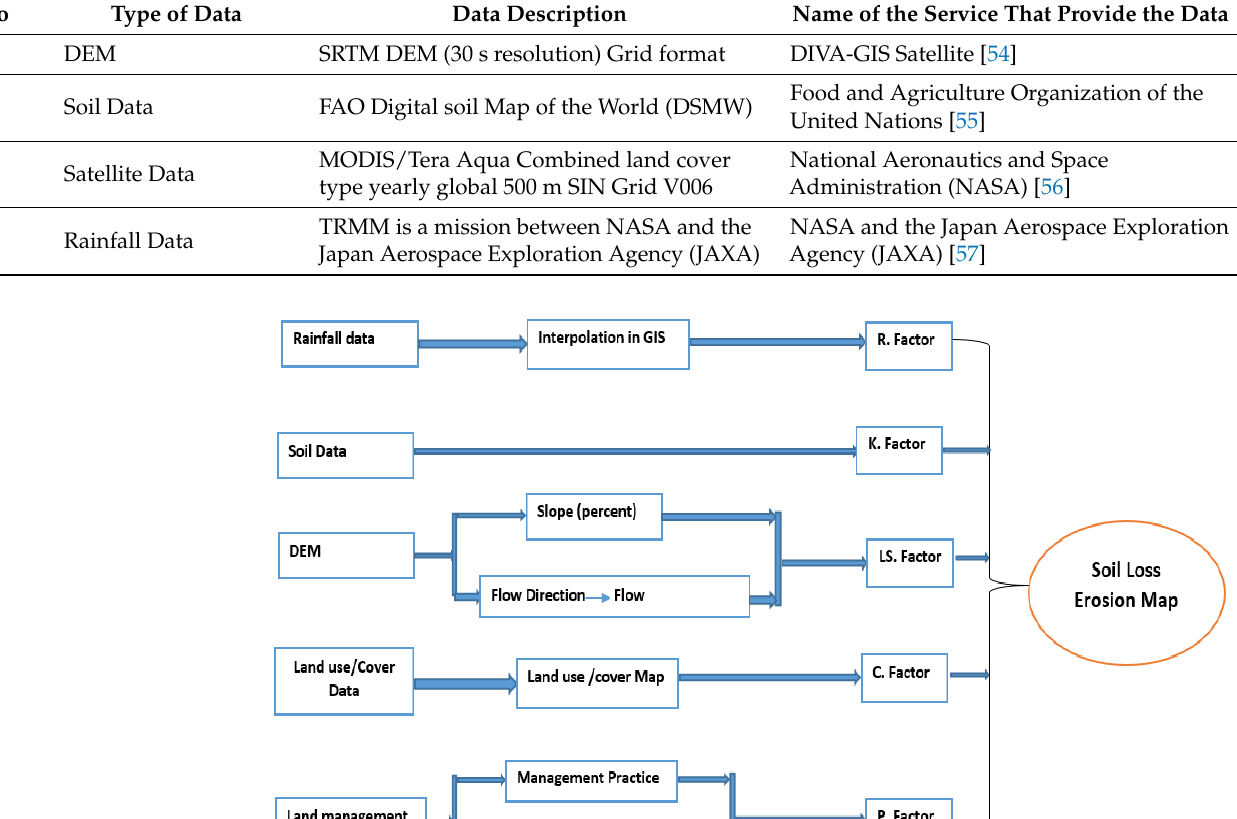
Table 1. Description of the data sources.